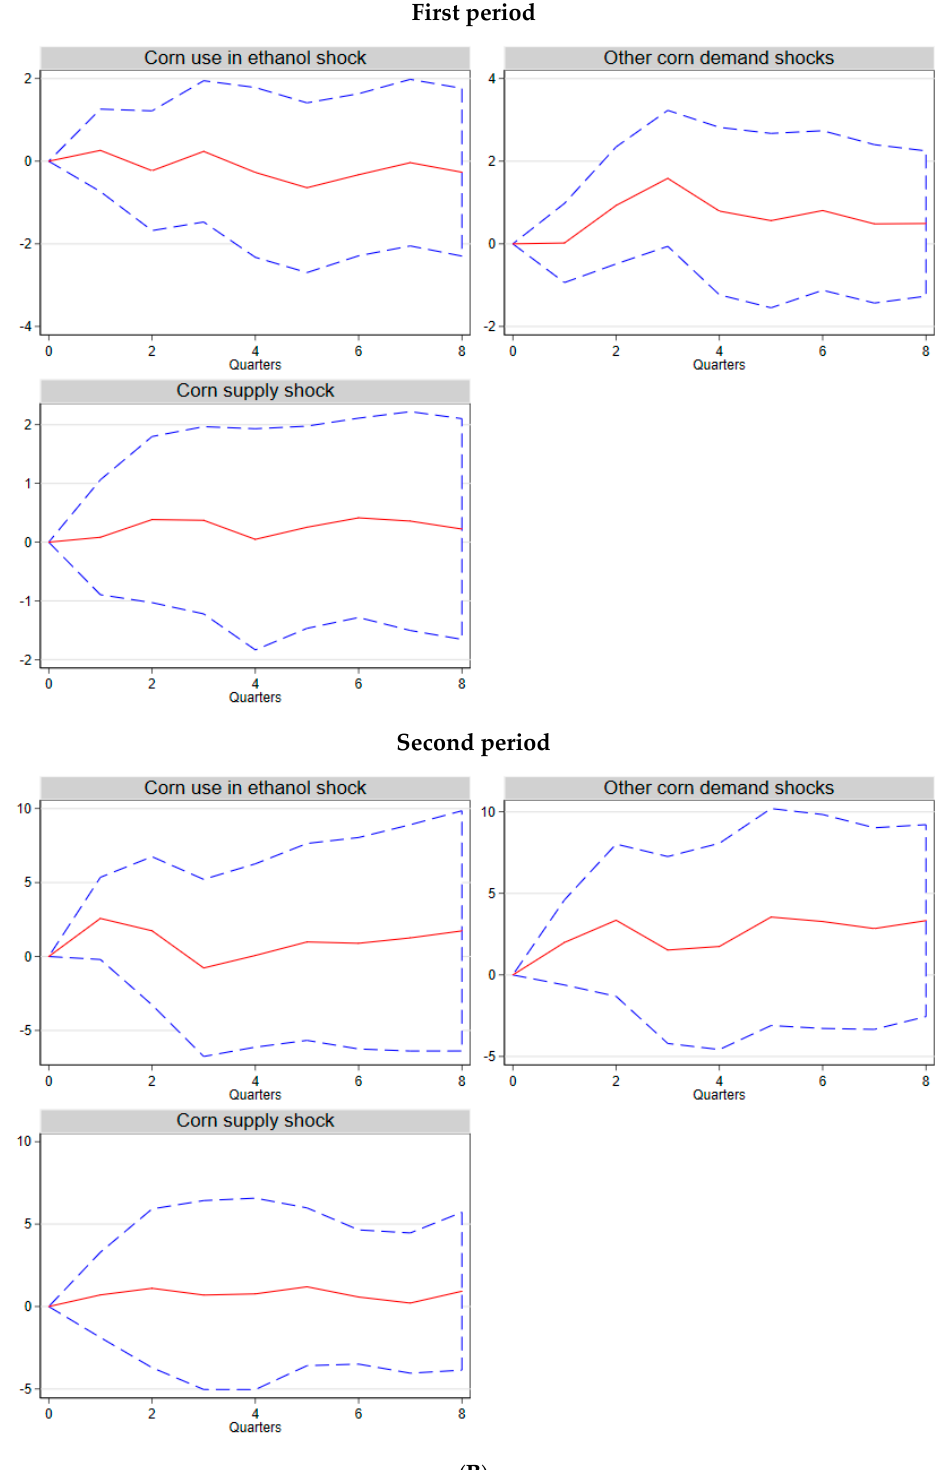
Figure 4. ( A ) Response of corn use in ethanol to oil price shocks. ( B ) Response of oil price to corn-related shocks. Notes: Red lines represent cumulative orthogonalized impulse–response functions while blue lines represent 95% confidence intervals.